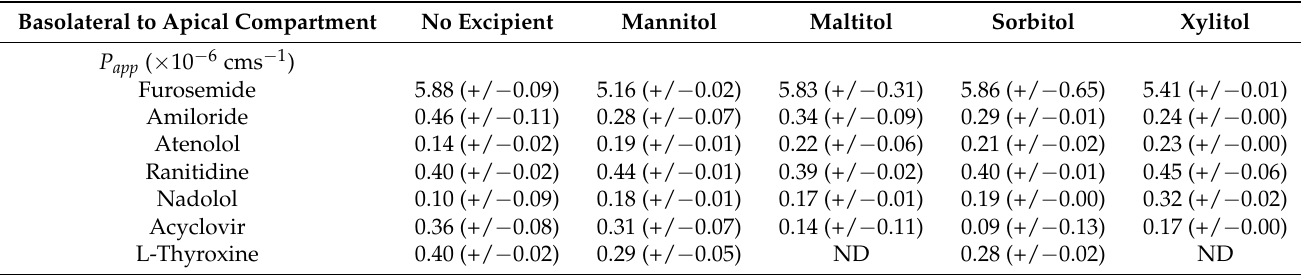
Table 6. Mean P app (+/ − standard deviation) of seven active substances basolateral to apical Caco-2 permeability assay, either alone or in the presence of an excipient (ND: not